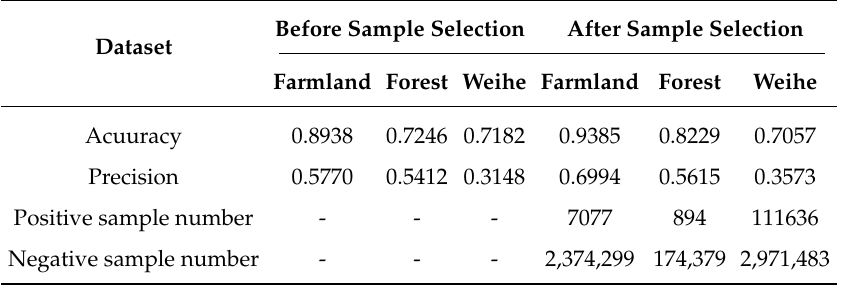
Table 2. Quantitative results of pre-classification of three